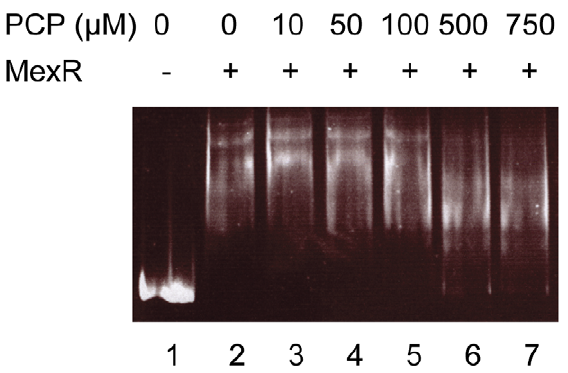
Figure 7. Lack of impact of PCP on MexR repressor binding to the mexR-mexA intergenic region. Mobility shift assay in which purified MexR-His (500 ng) was incubated with 40 ng of a 351-bp DNA fragment encompassing the mexR-mexA intergenic region and increas- ing amounts of PCP as indicated. Lane 1, DNA only control.